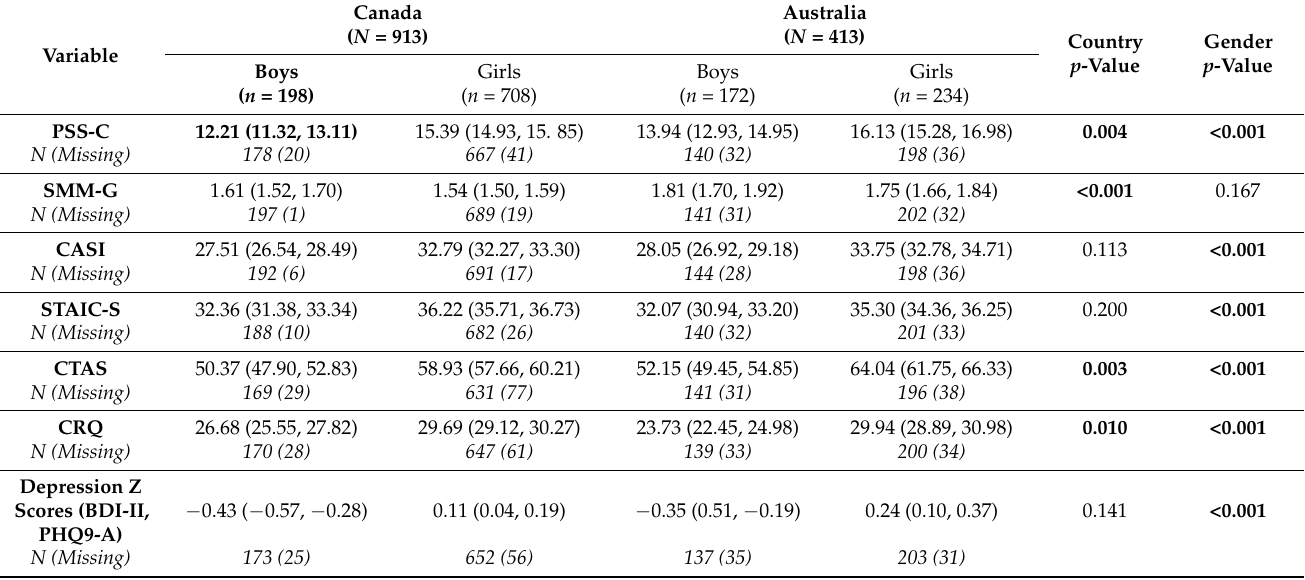
Table 1. Mean (95% CI) for Psychological Scales Stratified by Country and